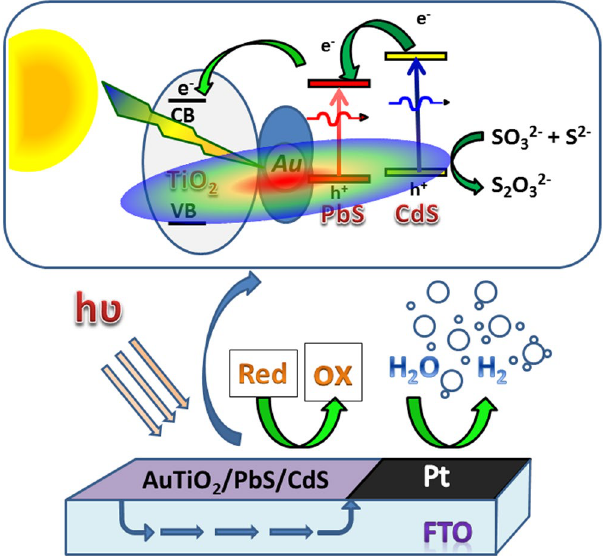
Figure 6. Schematic diagram for solar driven hydrogen evolution and the energy levels of different components. Au LSPR effect is represented by an